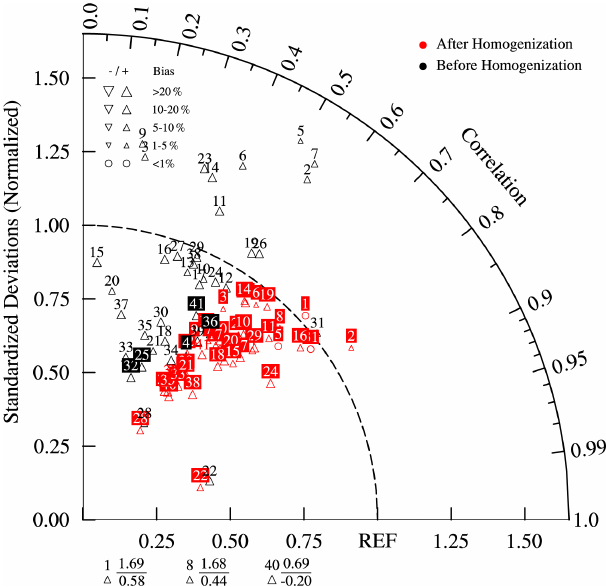
Figure 6. Taylor diagram describing the relative biases, standard- ized deviations, and correlation coefficients between the annual observed surface incident short-wave radiation ( R s ) and annual sunshine-duration-derived (SunDu-derived) R s before and after ho- mogenization at 41 selected stations (numbered 1–41 here). “REF” can be treated as the perfect point, where values the closer to this point indicate a better evaluation. The size and direction of the trian- gles denote the magnitude and negativity or positivity of biases, re- spectively. The boxes indicate the smaller bias in raw (black colour) or HM (red colour) series. This figure shows that biases decrease at most sites (in red boxes) after homogenization, except for the five stations numbered 4, 25, 32, 36, and 41 (in black boxes). Three sta- tions (numbered 1, 8, and 40 in black colour) listed below the panel are beyond the scope of the figure, with the bias (triangle), ratio of the standardized deviation (above the — line), and correlation coef- ficient (below the — line) shown. In addition to the improvements in the correlation coefficients after homogenization, the biases and the standard deviations generally become small in this Taylor